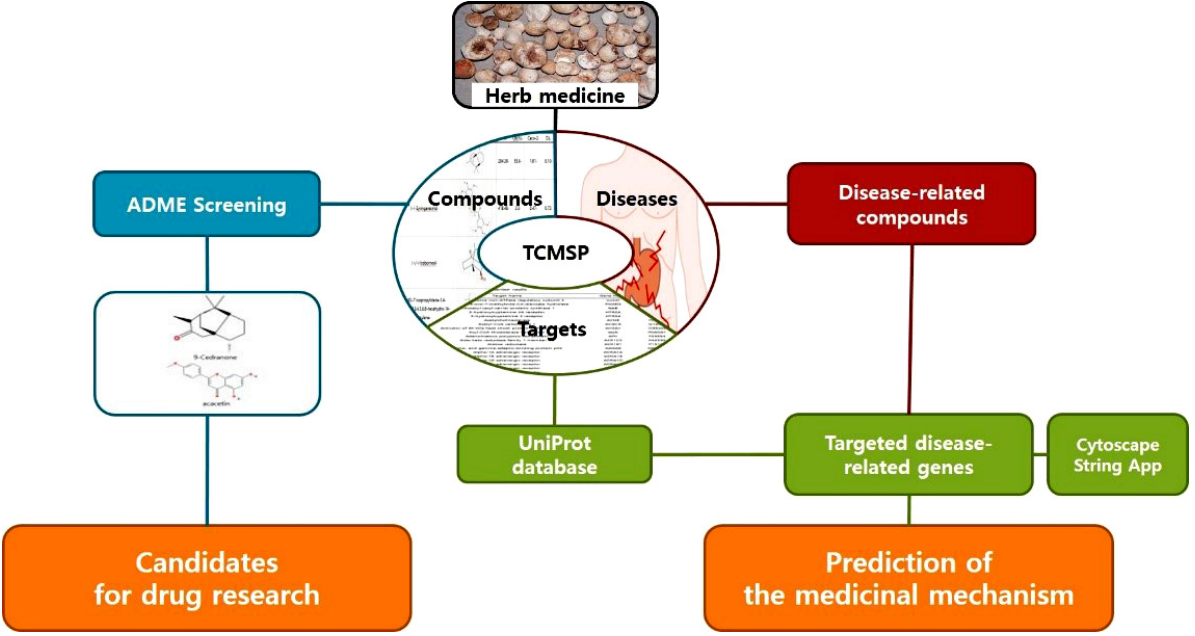
Figure 1. Schematic of the study protocol for network pharmacology exploration. ADME: absorp- tion, distribution, metabolism, and excretion.